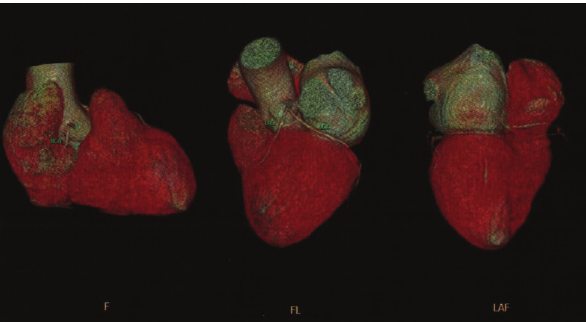
Figure 6: CT coronary angiography. There is no significant stenosis in the coronary arteries.